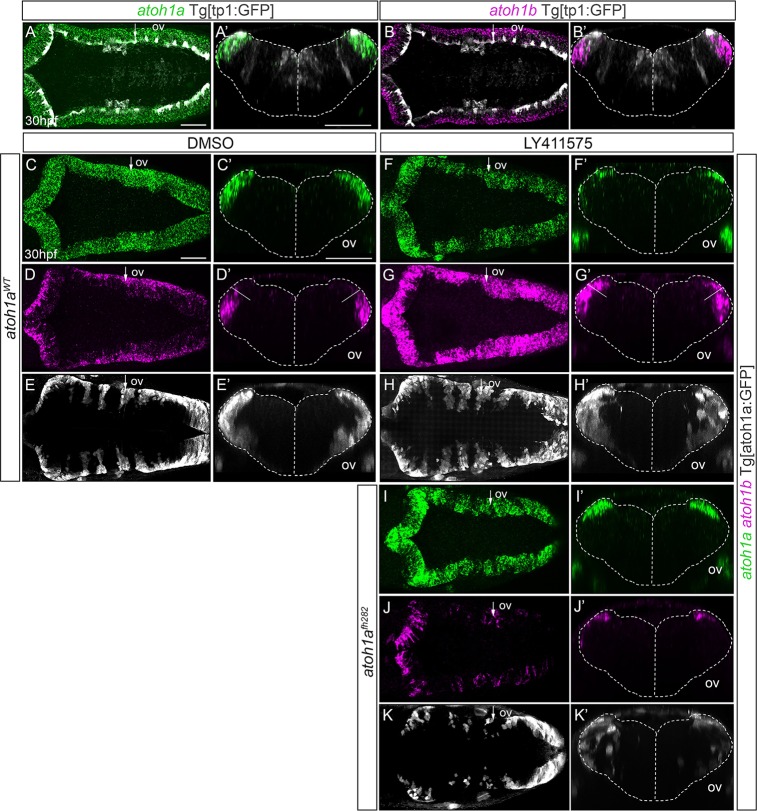
Notch-signaling regulates the transition of atoh1a cycling progenitors towards atoh1b committed cells.A-B) Whole mount double in situ hybridization with atoh1a (green) and atoh1b (magenta) in Tg[tp1:GFP] embryos (readout of Notch-activity in white). A’-B’) Reconstructed transverse views of embryos displayed as dorsal views in (A-B) through the point indicated by the white arrow. Note that Notch-activity is restricted to the most dorsomedial tip of the hindbrain, corresponding with atoh1a cells. C-K) atoh1aWTTg[atoh1:GFP] (C-H) and atoh1afh282Tg[atoh1:GFP] (I-K) siblings were double in situ hybridized with atoh1a (green) and atoh1b (magenta) after treatment with DMSO (C-E, n = 10) or the gamma-secretase inhibitor LY411575 (F-H, n = 15; I-K n = 3). The atoh1a derivatives were followed by anti-GFP staining in white. C’-K’) Reconstructed transverse views of embryos displayed as dorsal views in (C-K) at the level indicated by the white arrow. Note how the atoh1b-domain expands at expense of atoh1a progenitors after blocking Notch-activity in wild type embryos, but not in atoh1afh282 mutants. A-D, F-G, I-J) Dorsal views of confocal MIP from dorsal stacks with anterior to the left. E, H, K) Dorsal views of confocal MIP from ventral hindbrain with anterior to the left. ov, otic vesicle. Scale bars correspond to 50 μm.